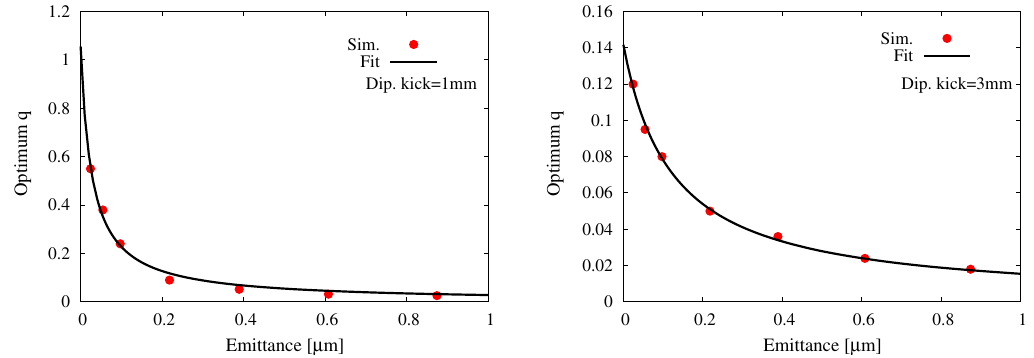
FIG. 7. Optimum quadrupole strength as a function of the initial emittance for two initial dipole kicks: simulations (red dots) compared with fits to the form in Eq. (4.1).